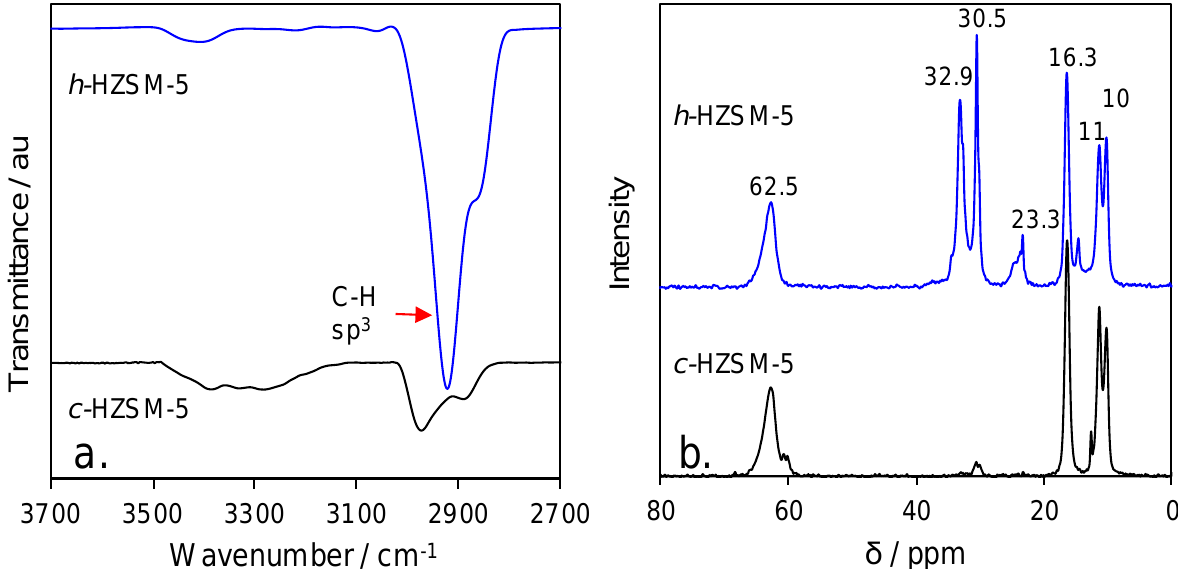
Figure 3. ( a ) ATR-IR) and ( b ) 13 C NMR spectra of uncalcined h-HZSM-5 and c-HZSM-5.